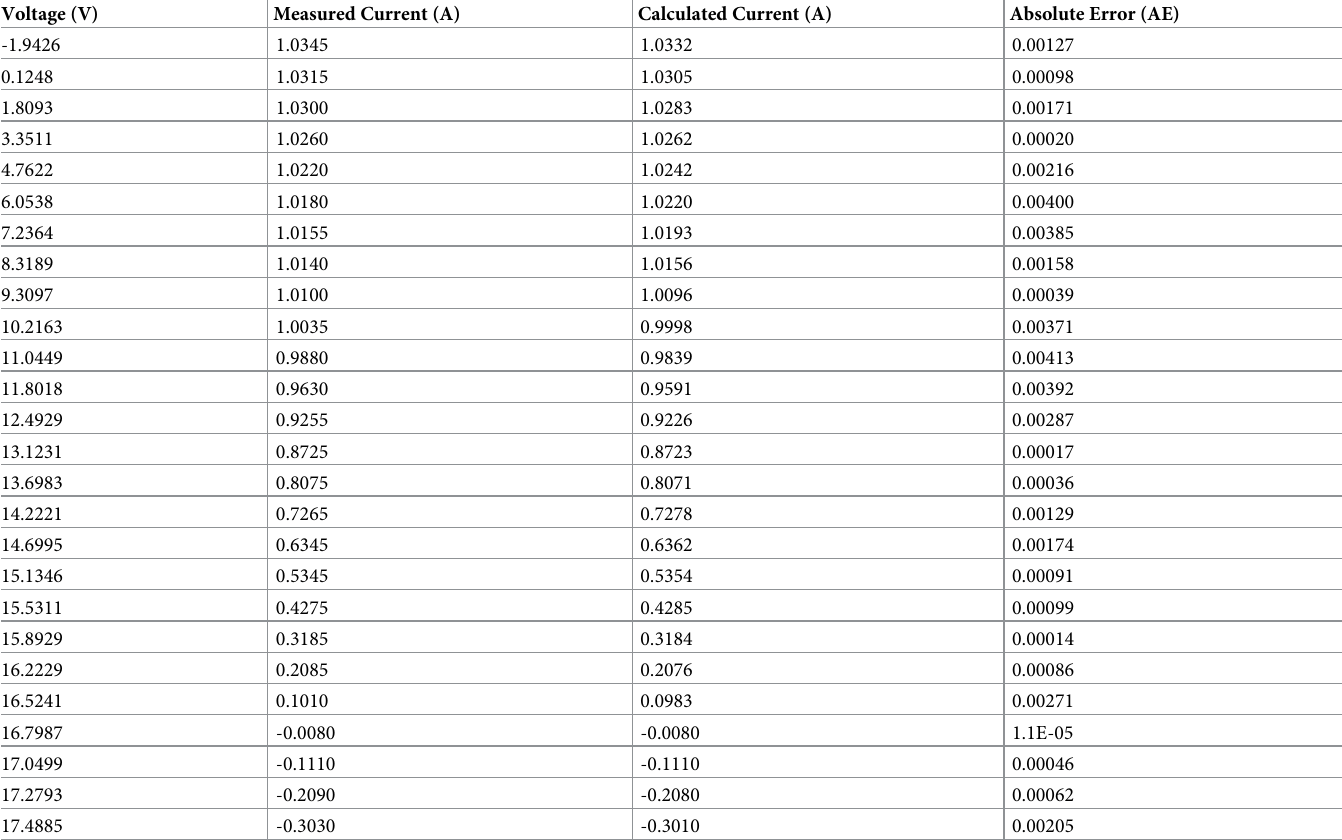
Table 5. Calculated/simulated results for single-diode model of Photowatt-PWP201 module tested using ACT. Voltage